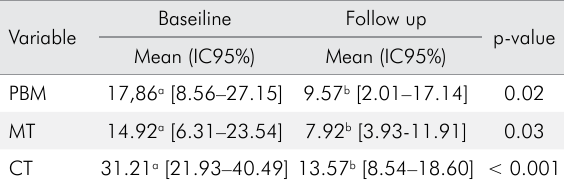
Table 8. RDC axis II: Analysis of jaw disability (D4) at baseline and follow up.